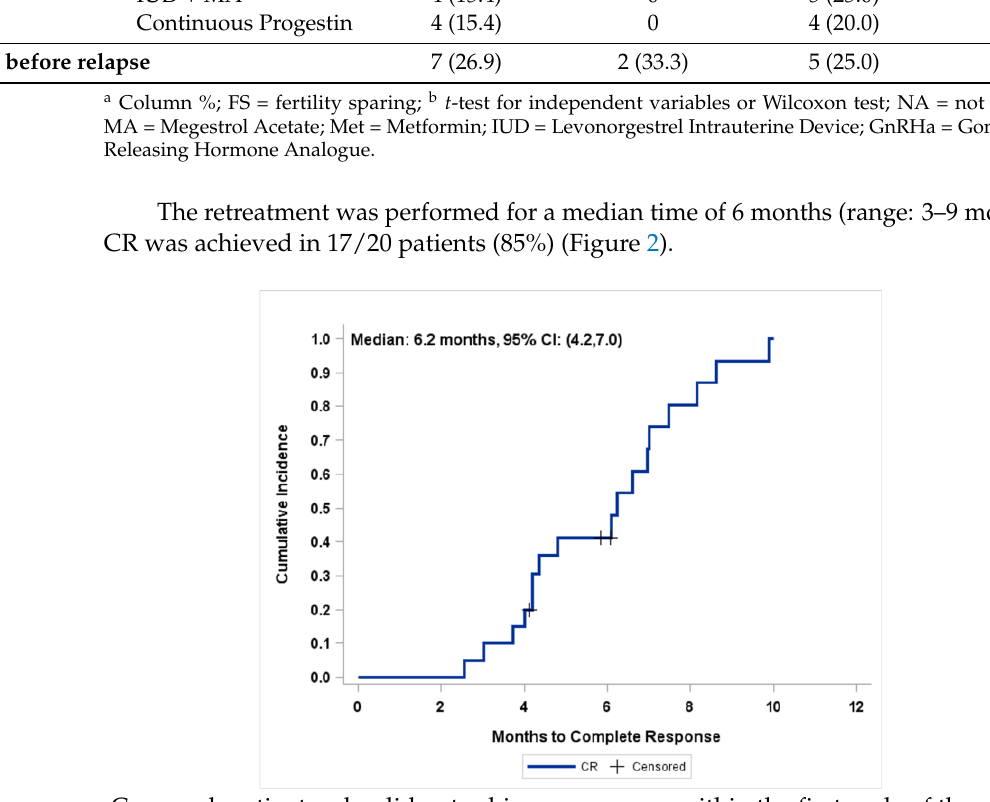
Figure 2. Cumulative incidence of complete responses, N = 20 patients. Of the remaining patients, 2/20 (10%) showed SD on the follow-up biopsy and contin- ued the treatment with the LNG-IUD for 6 months more. After that, both patients achieved a CR (95% CR at 15 months). Only one patient (5%) showed PD at the follow-up biopsy (endometrioid endometrial carcinoma G3) and underwent demolitive treatment. However, the final histological uterine specimens after hysterectomy showed